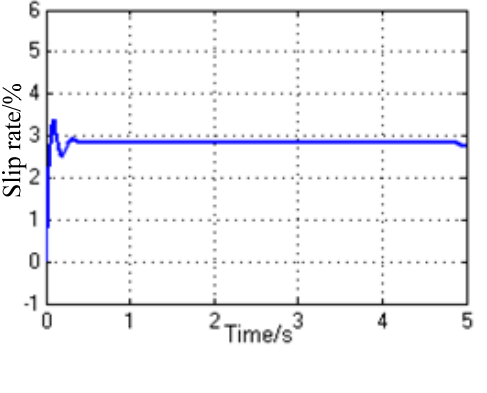
Figure 3. The modified tyre slip rate at a low vehicle